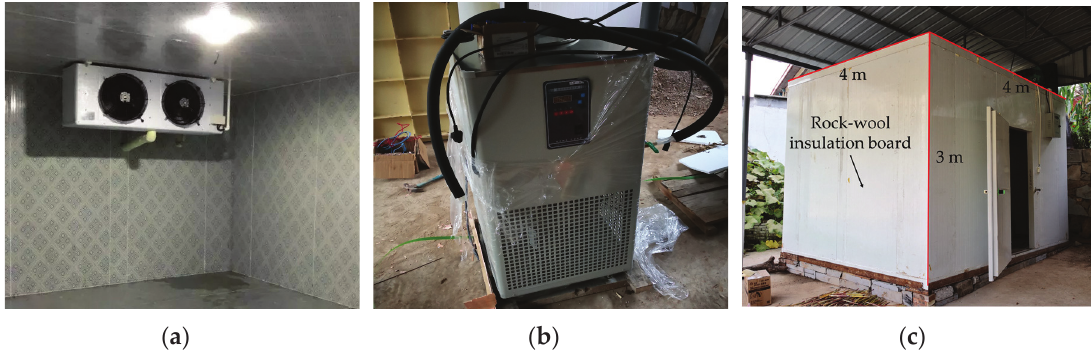
Figure 4. Refrigeration system: photo of ( a ) external refrigerator, ( b ) internal cycle refrigerator, and ( c ) constant temperature chamber.